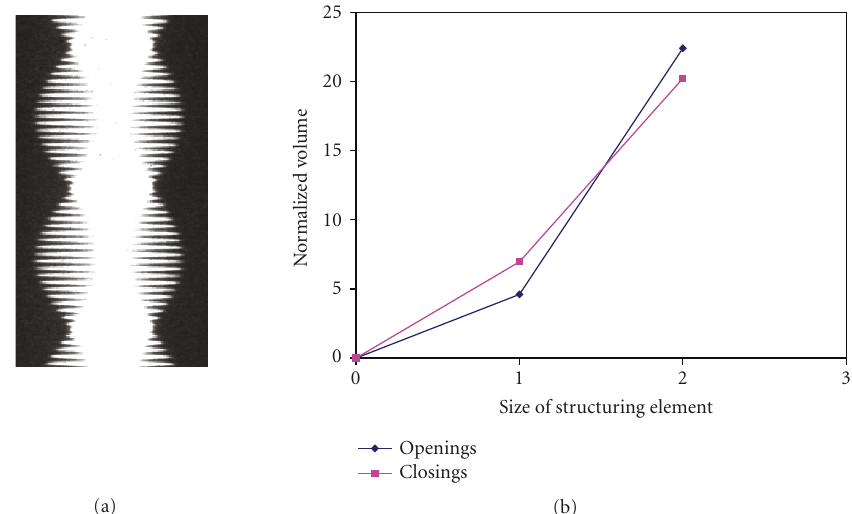
Figure 15: Succession of openings and closings with vertical structuring elements applied to an overexposed soundtrack.